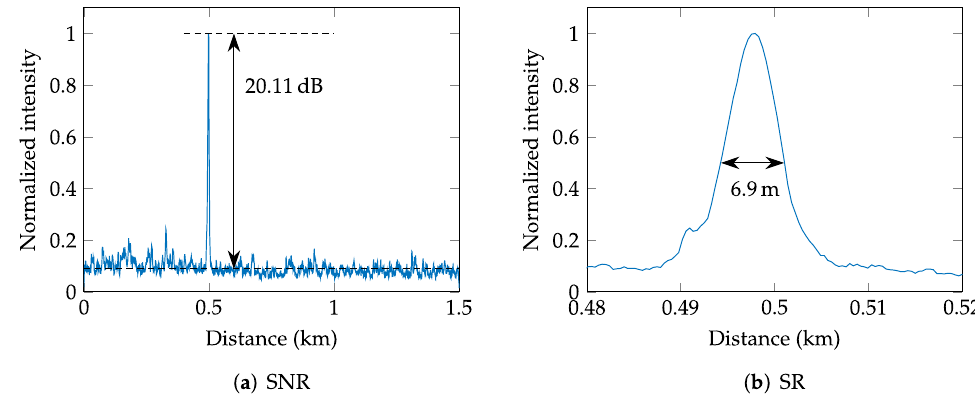
Figure 8. Example of SNR and SR